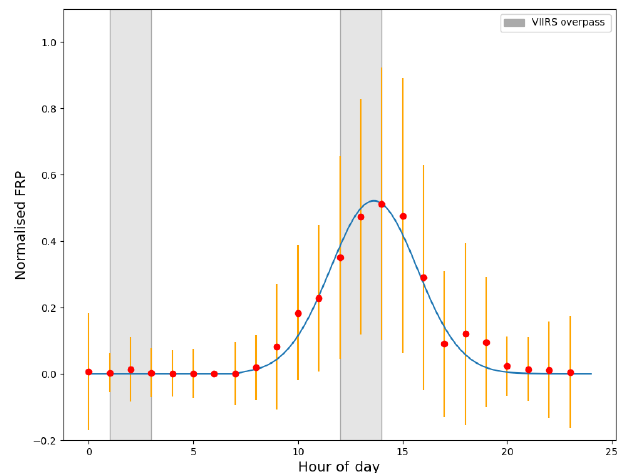
Figure 4. Time series of hourly normalised fire radiative power de- rived from Himawari-8 FRP data generated using the algorithm of Xu et al. (2017) over eastern China at 0.1 ◦ for June 2015 (the “sum- mer” diurnal fire cycle). The blue curve shows the best fit of the Gaussian distribution, with the orange error bar showing the stan- dard deviation. Grey shading shows the two daily VIIRS overpass